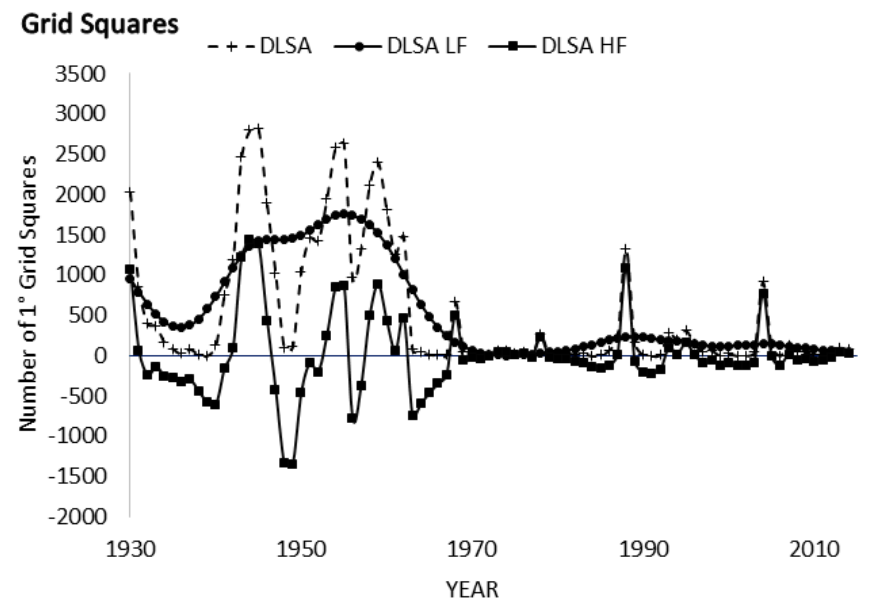
Figure 6. Numbers of 1° grid squares infested with swarms of Desert Locusts 1930–2014 (DLSA, crosses), together with results of Kalman filtering to provide low frequency components (circles) and high frequency components (squares).